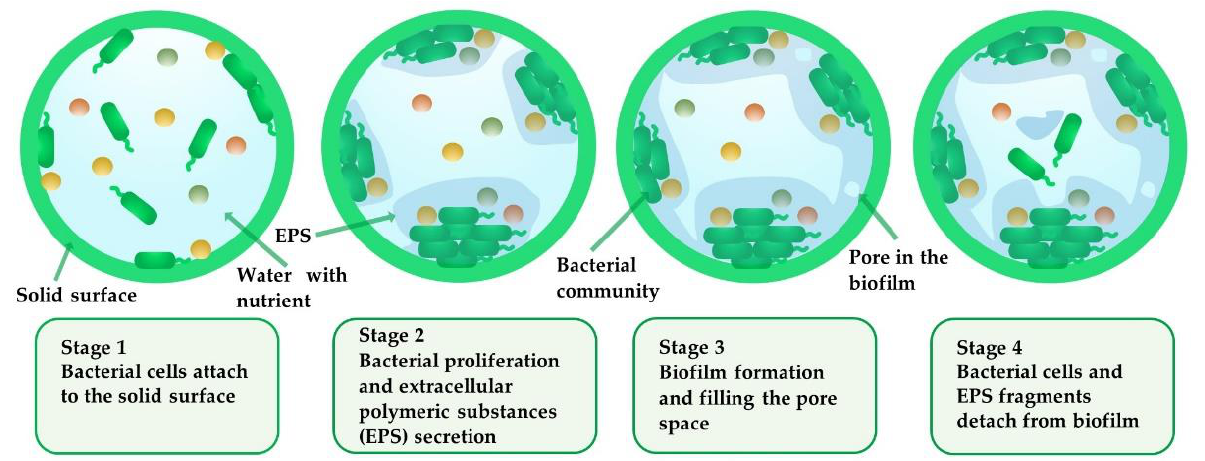
Figure 1. Biofilm development processes in a pore.